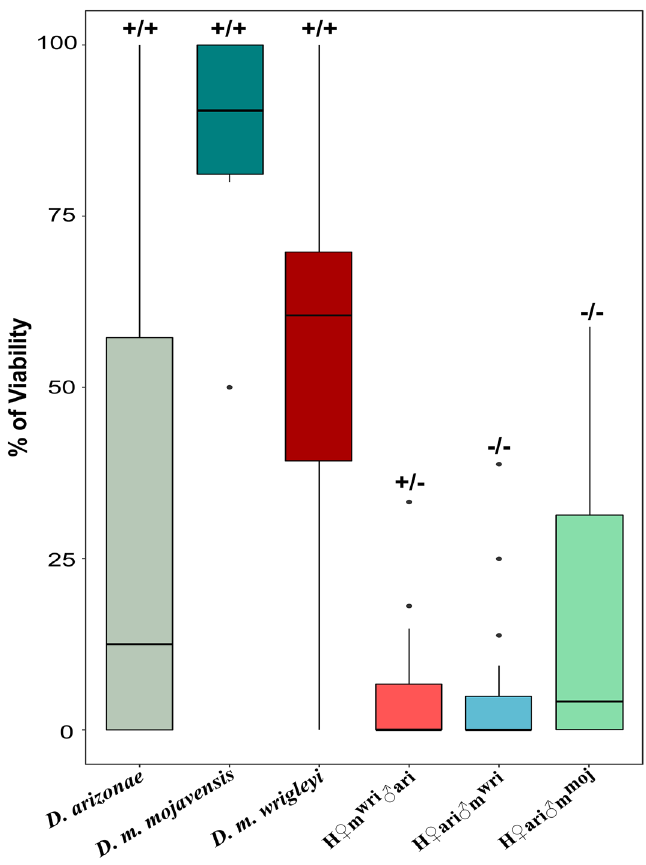
Figure 6. Average viability and fertility of intraspecific and interspecific offspring. Average viability (%) of D. arizonae, D. m. wrigleyi and D. m. mojavensis and their respective hybrids, H ♀ m wri ♂ ari, H ♀ ari ♂ m wri and H ♀ ari ♂ m moj . Sperm motility and fertility are represented by—and + signals. +/+: motile sperm/fertile, +/−: motile sperm/sterile, −/− amotile sperm/sterile. The boxplot was generated using the ggplot2 package (version 3.3.3) in R 79